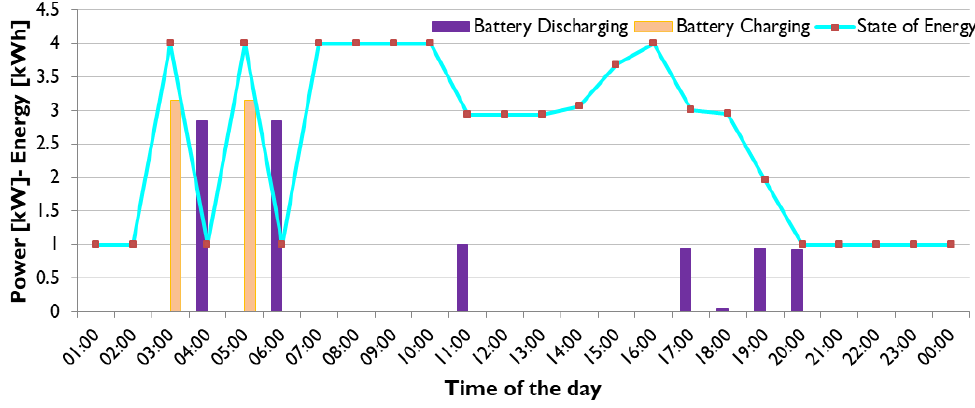
Figure 11. Battery charging and discharging power along with state of energy variation for sample winter case.